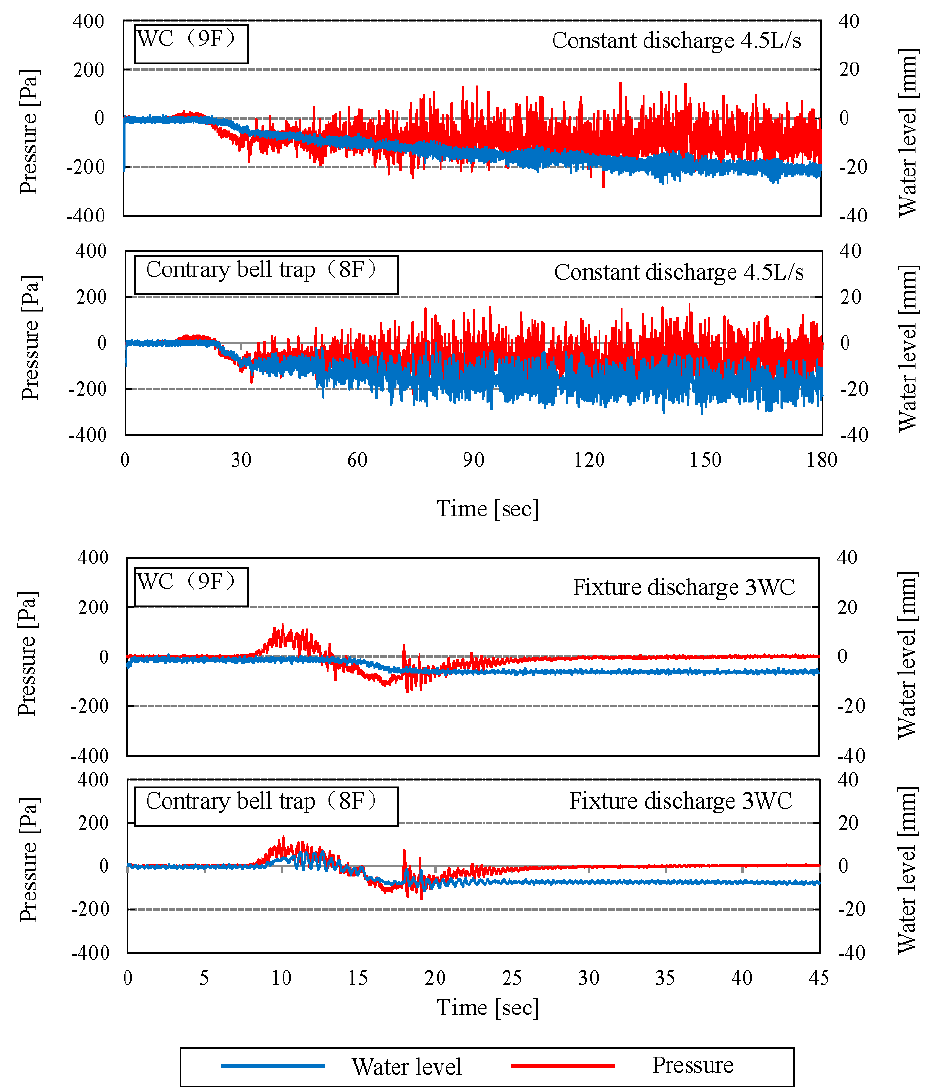
Figure 6. Examples of the wave patterns of pressure vibration in pipes and seal water Figure 6 . Examples of the wave patterns of pressure vibration in pipes and seal water fluctuation.